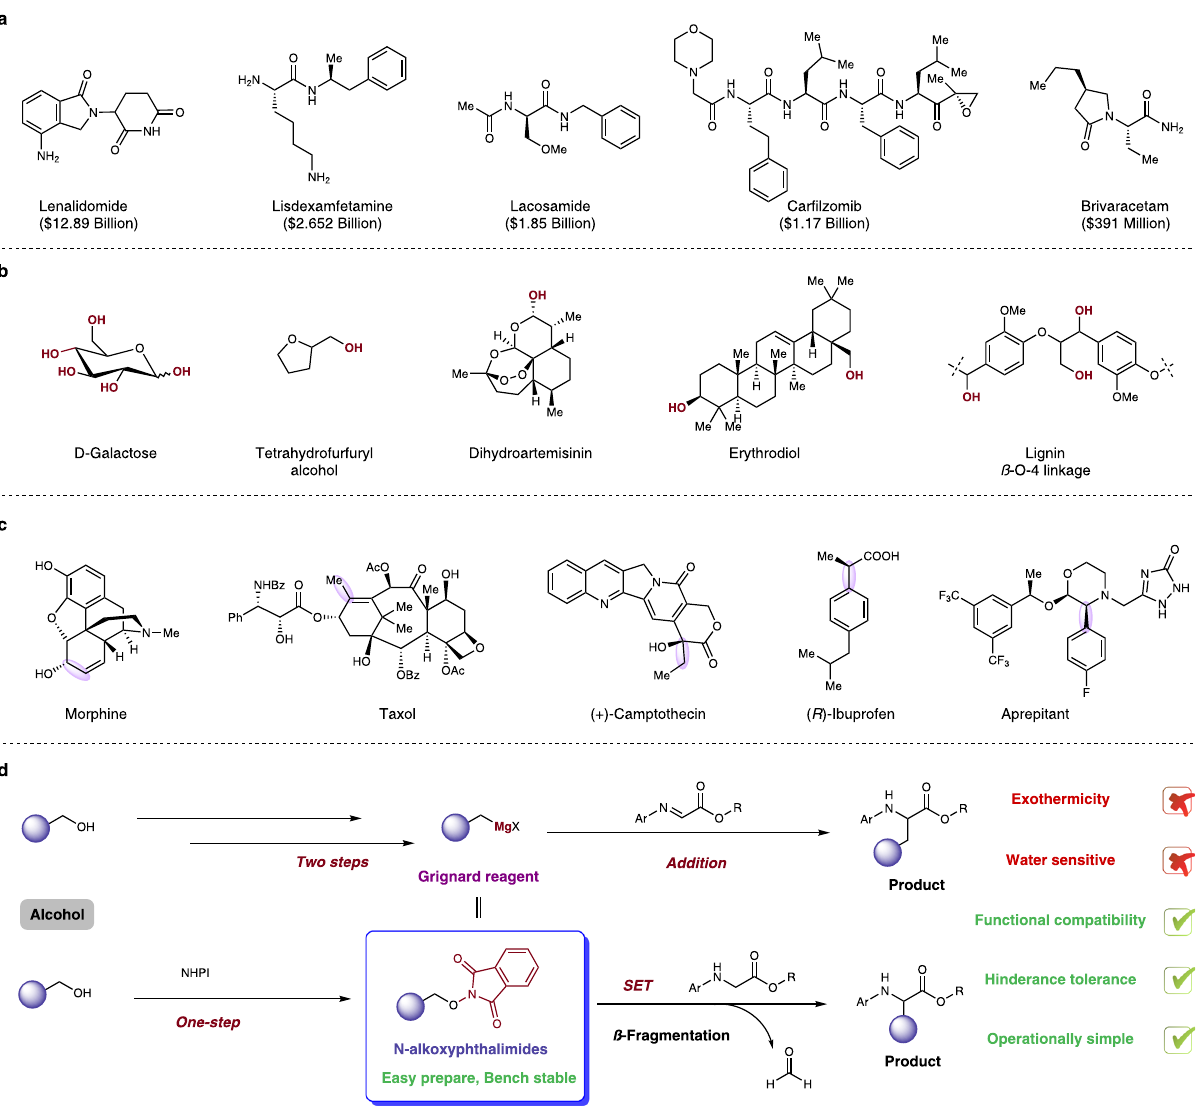
Fig. 1 | Project background and design plan. a Various drugs derived from α - amino acid; b Representative biomass derivatives, pharmaceuticals, and natural products containing hydroxy functional group; c Pharmaceutical and natural pro- ducts syntheses featuring the Grignard reaction (formed bonds highlighted in